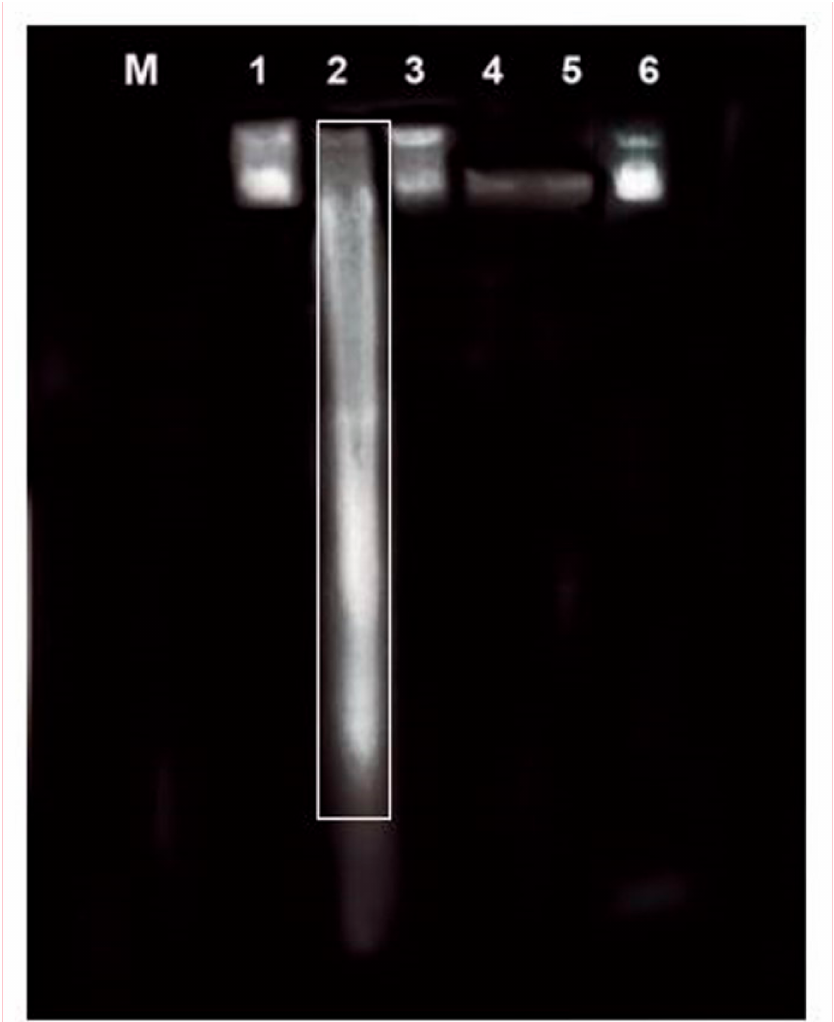
Figure 6. E ff ect of CP (150 mg / kg / i.p) and di ff erent doses of RKs (25, 50, 100, 200 mg / kg / p.o) on the integrity of nuclear DNA (nDNA) extracted from lung tissues of male mice ( n = 3). Lane M, 100 kb DNA ladder; intact nDNA of Control (lane 1) and (lane 2) CP-treated mice, nDNA samples of RKs with di ff erent treated doses such as: RKs (25 mg / kg / p.o) of (lane 3), RKs (50 mg / kg / p.o) of (lane 4), RKs (100 mg / kg / p.o) of (lane 5), and finally RKs (200 mg / kg / p.o) of (lane 6) for 2 weeks before acute exposure to CP (150 mg / kg /